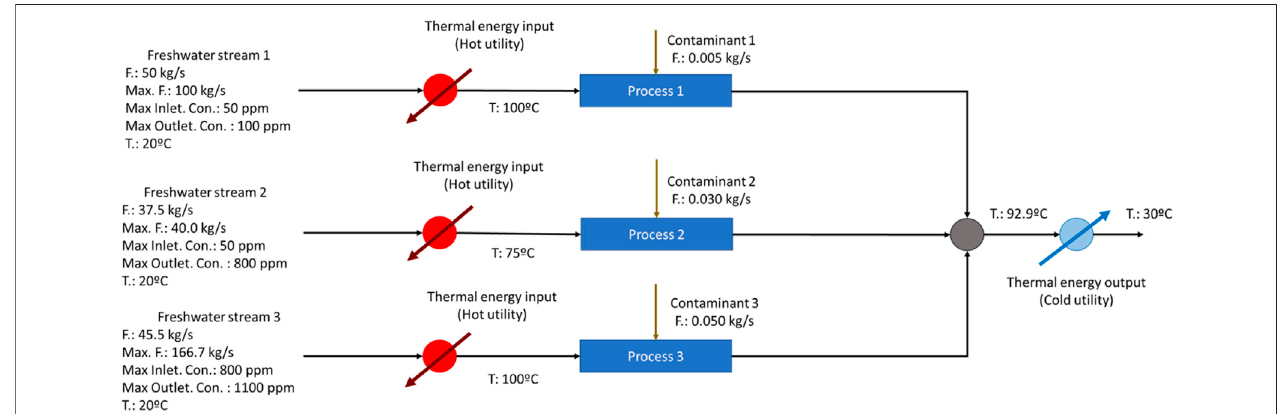
FIGURE 1 | Flowsheet of the industrial system [adapted from (Boix et al., 2012)].